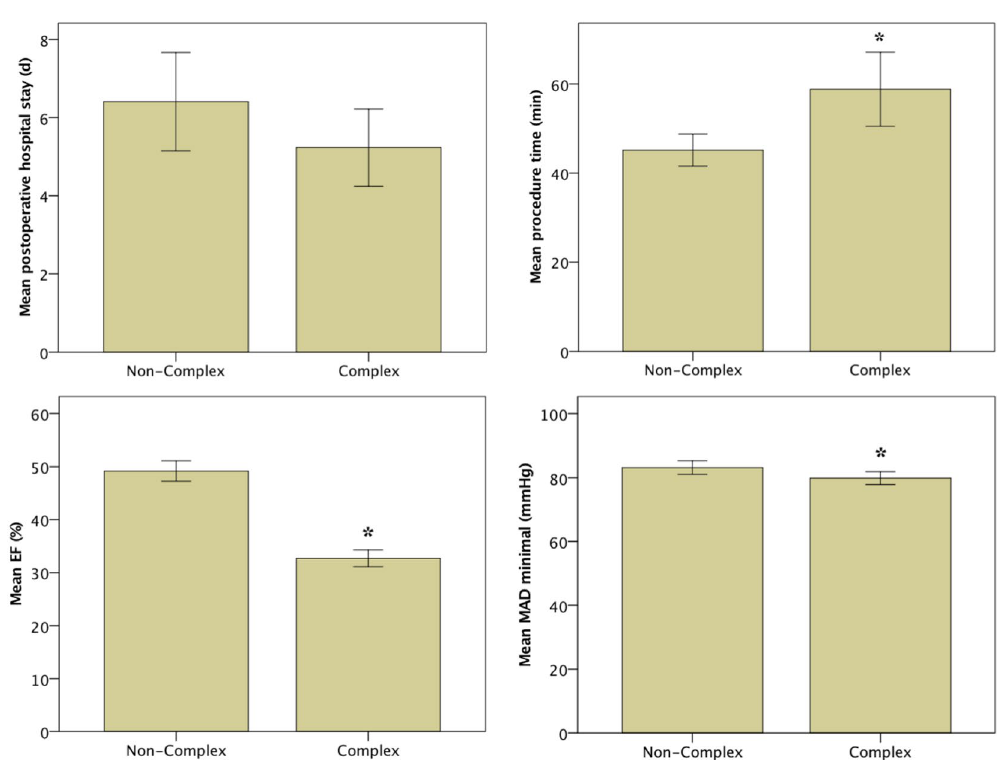
Figure 2. Procedural details for noncomplex and complex cardiac implantable electronic device procedures. Despite a significantly longer procedure time and significantly lower ejection fraction (EF) in the complex group, the minimal mean arterial pressure (MAP) and postoperative stay are comparable between the two groups. The error bars represent the standard error of the mean (2 SE). * p <